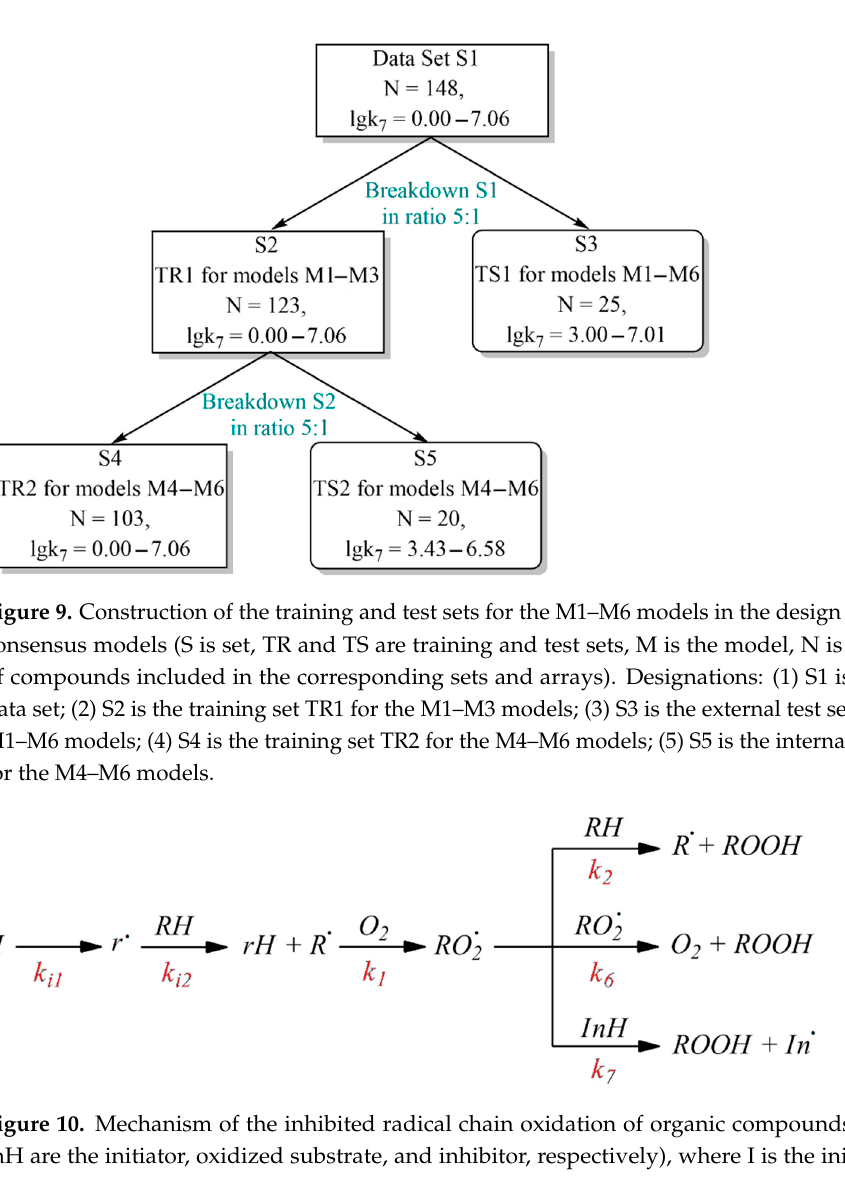
Figure 10. Mechanism of the inhibited radical chain oxidation of organic compounds (I, RH and InH are the initiator, oxidized substrate, and inhibitor, respectively), where I is the initiator of the oxida-